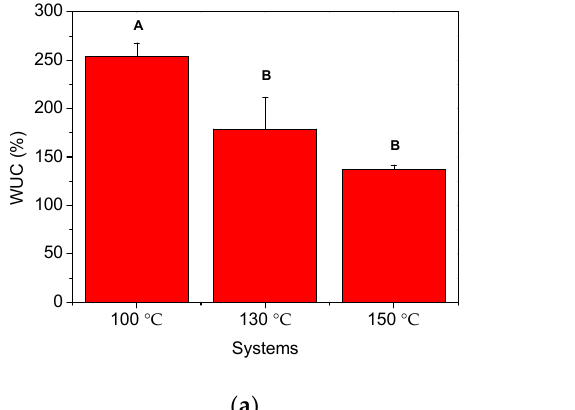
Figure 5. SEM micrographs after lyophilization of the different samples at ( a ) 100 ° C; ( b ) 130 ° C; ( c ) 150 ° C. 4. Discussion 4.1. Chemical Composition The chemical composition of the sample was successfully evaluated, leading to sim- ilar results to those obtained by Siswanti et al. [30] and Thiranan et al. [31] for red and defatted rice bran. According to these research works, the majority of the sample accounts for carbohydrates; thus, the non-identified percentage of the rice bran under evaluation can be attributed to this basic food group. Furthermore, the characterization carried out by Klanwan et al. [16] revealed a variety of this byproduct with a very similar composi- tion, which was employed for the same purpose (bioplastic production), suggesting the( a ) ( b ) ( c )